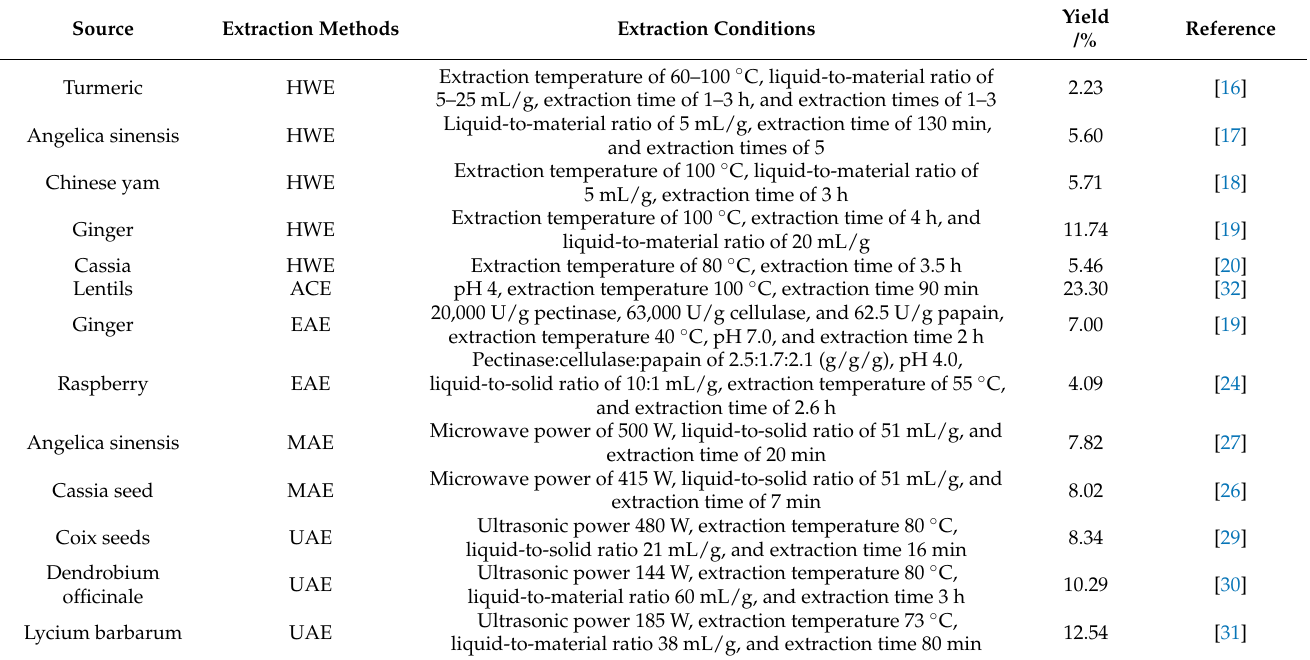
Table 1. Extraction methods of